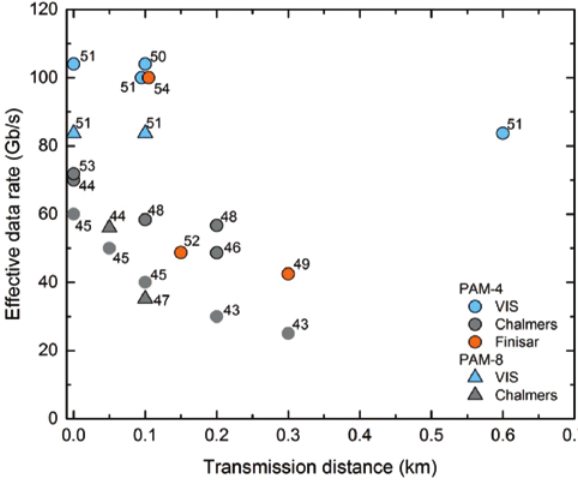
Figure 17: Effective data rate vs. MMF transmission distance for 4-PAM and